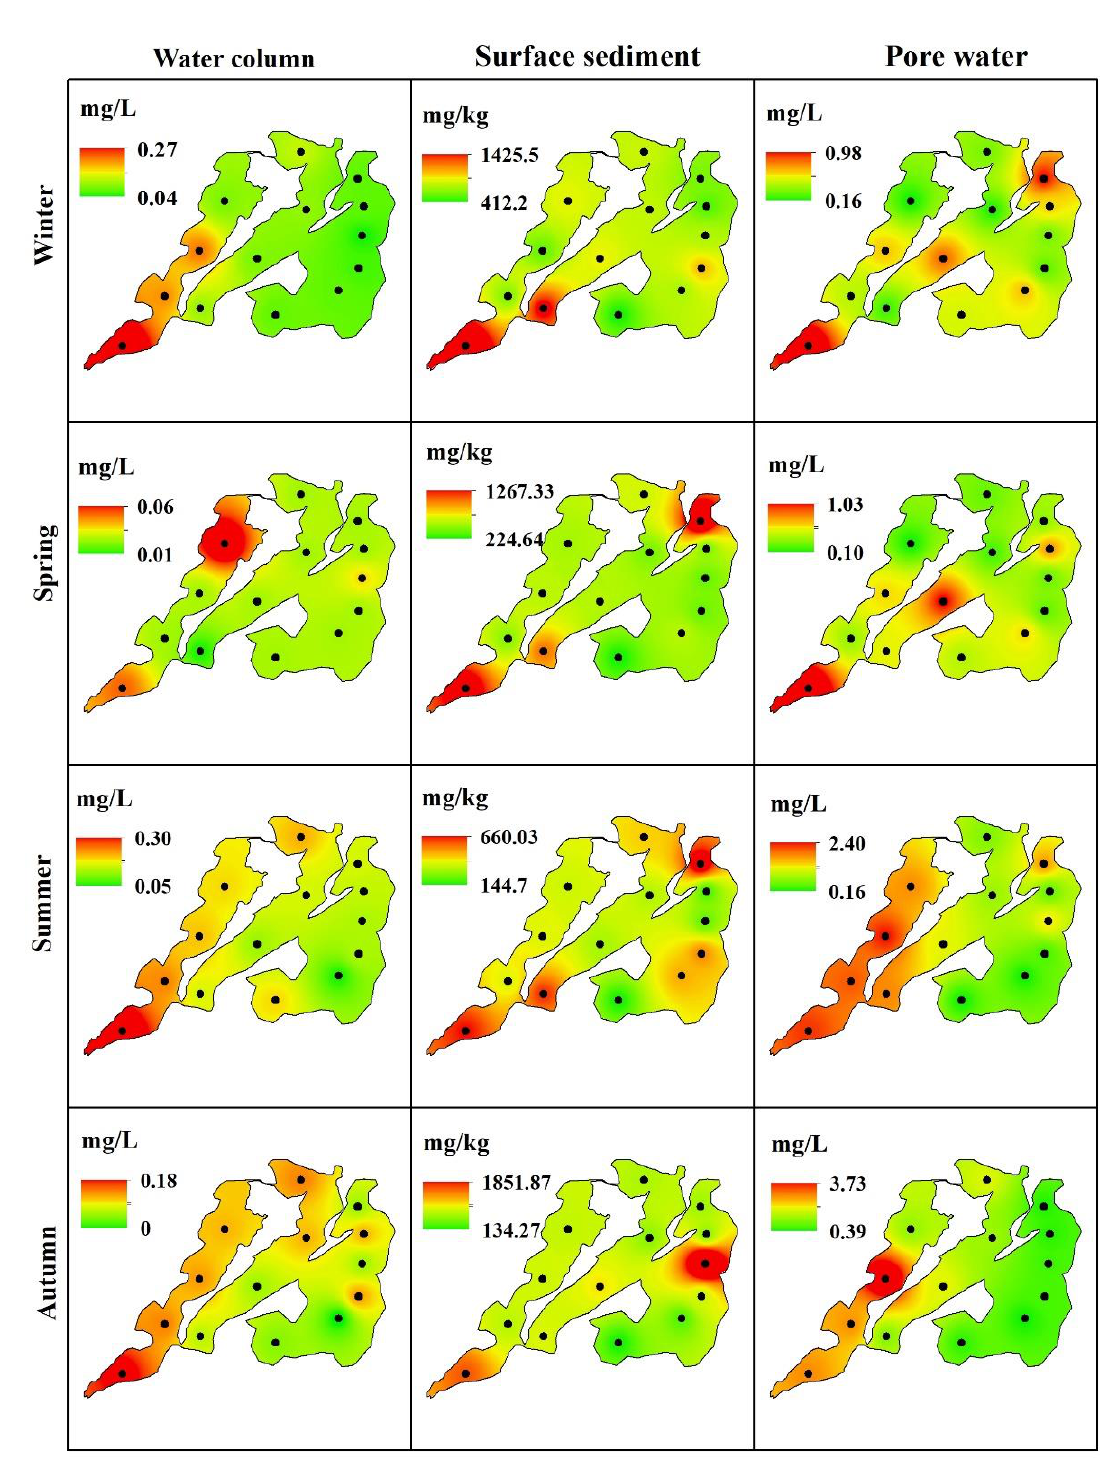
Figure 3. The seasonal variation of TP in the water column, surface sediment, and pore water displayed according to the values of 14 sampling sites in Lake Yangcheng. The colored areas indicate the concentrations of TP at the sampling sites. The color spectrum ranges from green (lowest) to red (highest).